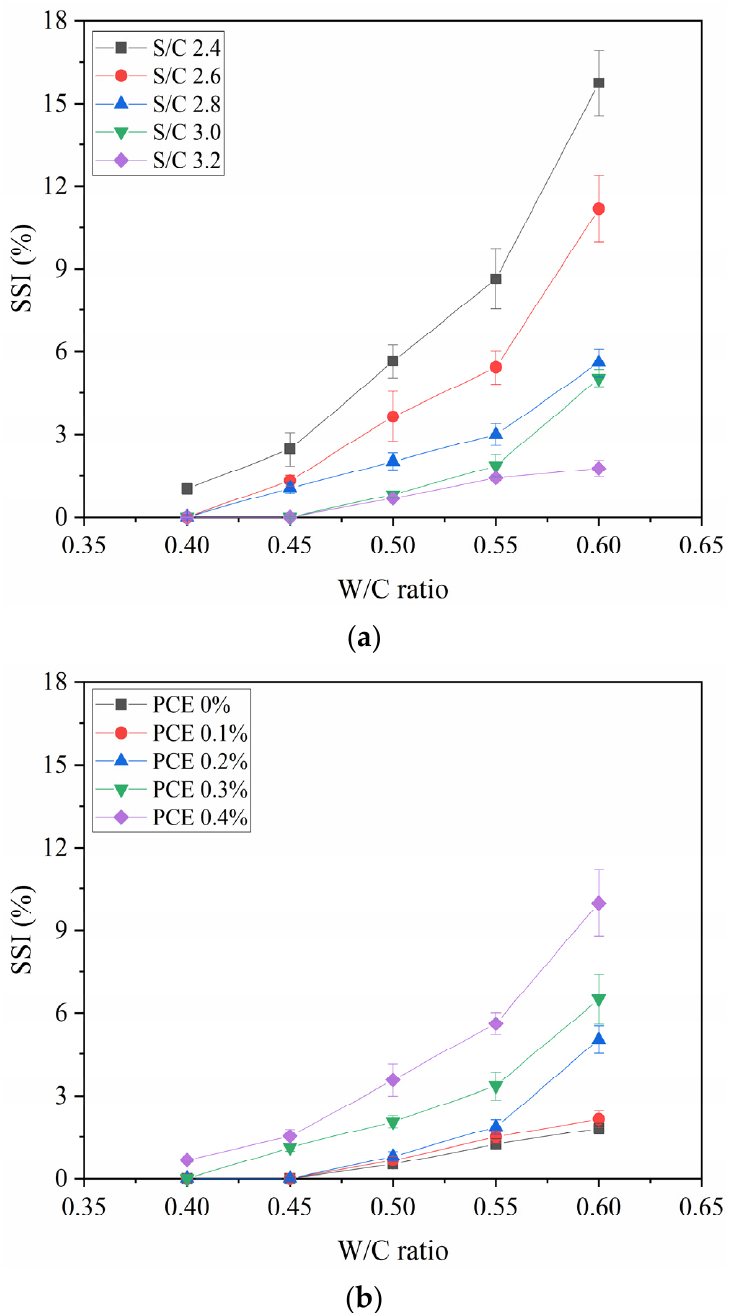
Figure 5. SSI versus W/C Ratio: ( a ) different S/C ratios, ( b ) different PCE dosages.